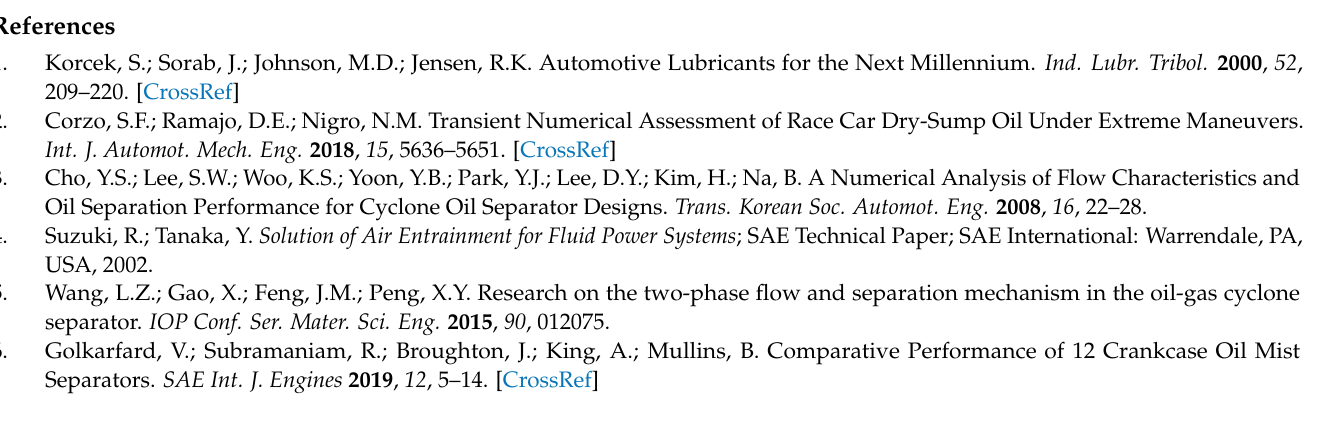
Figure 14. Volume fraction of added lateral acceleration during vortex collapse.